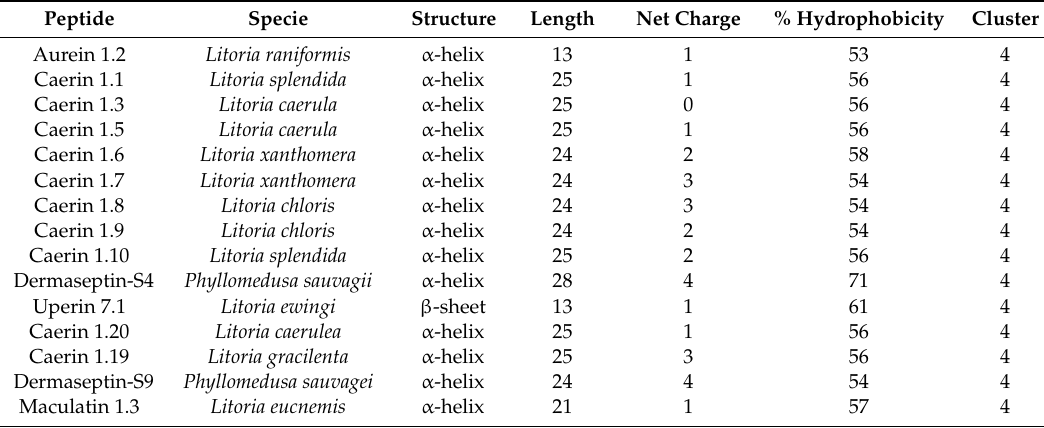
Figure 1. Characteristics from Cluster 4. ( A ) Frequency of organisms and secondary structures in cluster 4; ( B ) Frequency of amphibian families in cluster 4. ( C ) Phylogenetic tree between Hylidae peptides from cluster 4. Table 2. AMPs from Hylidae amphibian Hylidae family in cluster 4.